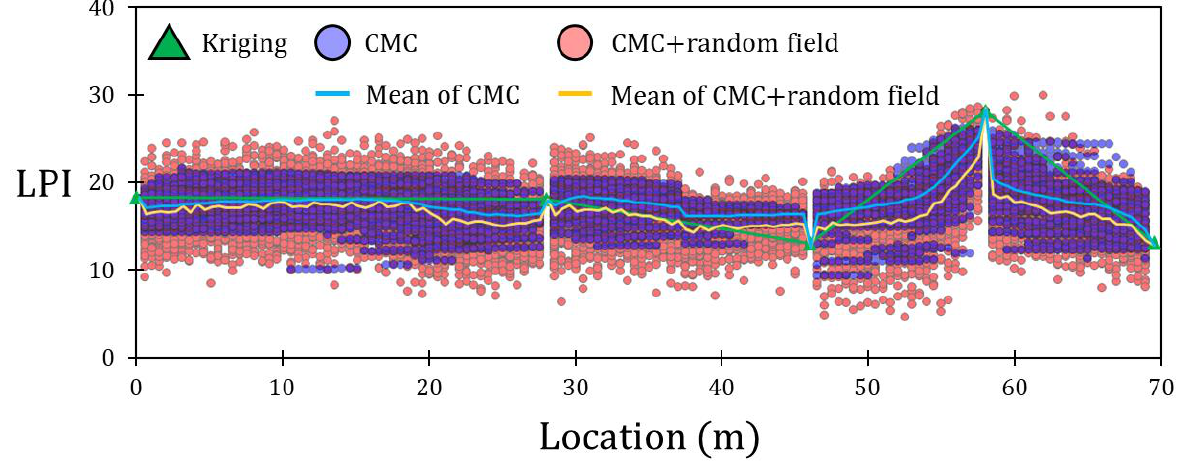
Figure 10. Comparison of the liquefaction-potential-evaluation results of three models through the HBF method (100 cyc.).